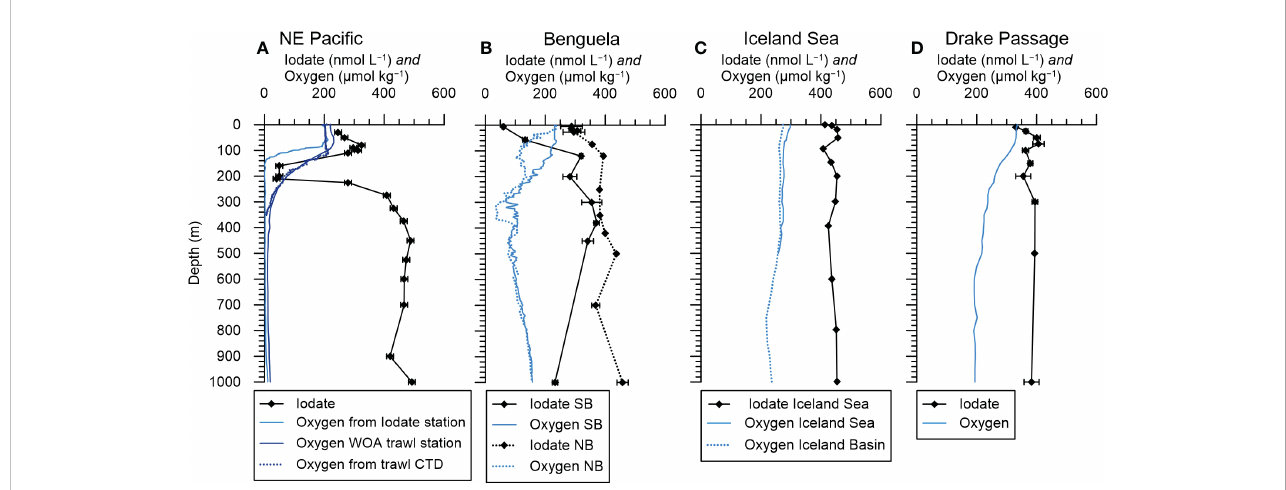
FIGURE 2 Representative pro fi les of oxygen and iodate concentrations from selected stations for comparison with foraminifera I/Ca ratios. (A) Station F19 in the NE Paci fi c. Oxygen from Evans et al. (2020) and iodate from Moriyasu et al. (2020). The plankton net sample for the North-East Paci fi c is 400 km away from the iodate pro fi le station and an oxygen pro fi le from the plankton trawl station (Wishner et al., 2018) is shown along the closest WOA18 grid point pro fi le. (B) South Benguela (SB, continuous lines, CTD cast 7) and North Benguela (NB, dotted lines, CTD cast 18). (C) Iceland Basin iodate pro fi le from Waite et al. (2006) and oxygen from WOA18 (Garcia et al., 2019). (D) Drake Passage iodate pro fi le (PS71/232-1) from Bluhm et al. (2011) and oxygen from WOA18 (Garcia et al.,